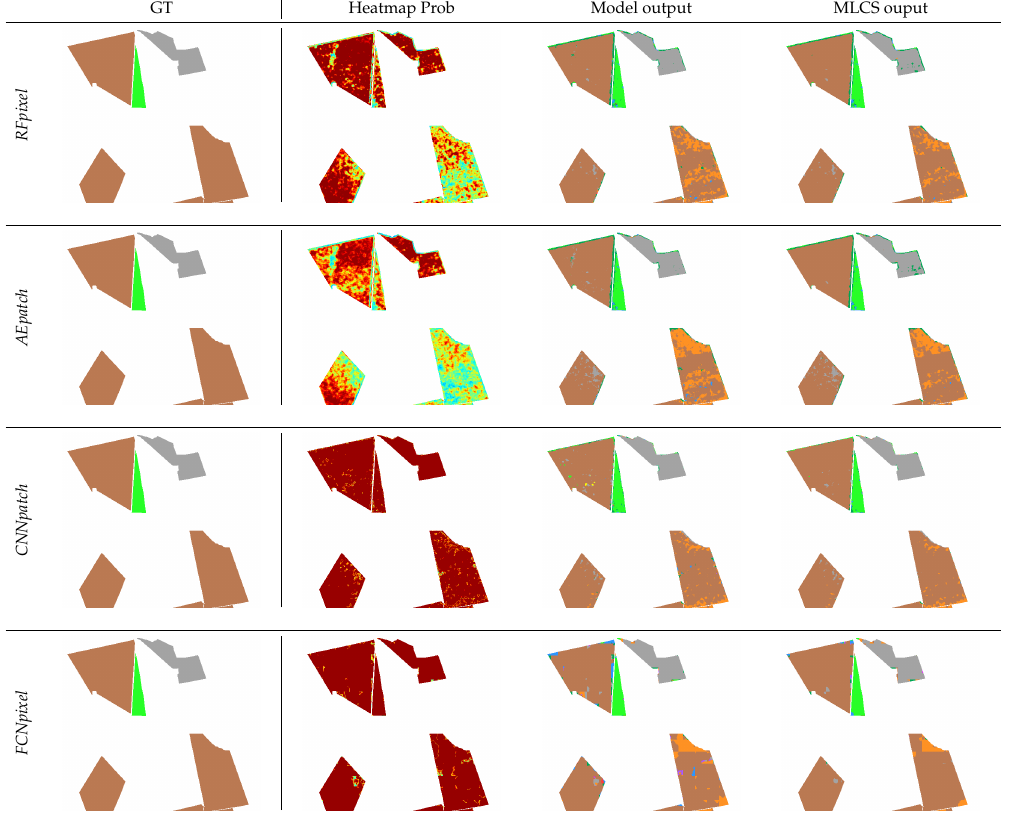
Figure 18. Maps of the class output before and after MLCS for each method for selected area on December 2016. GT stands for ground truth and Heatmap Prob for a heat map of the output probabilities. Same color legend as in Figure